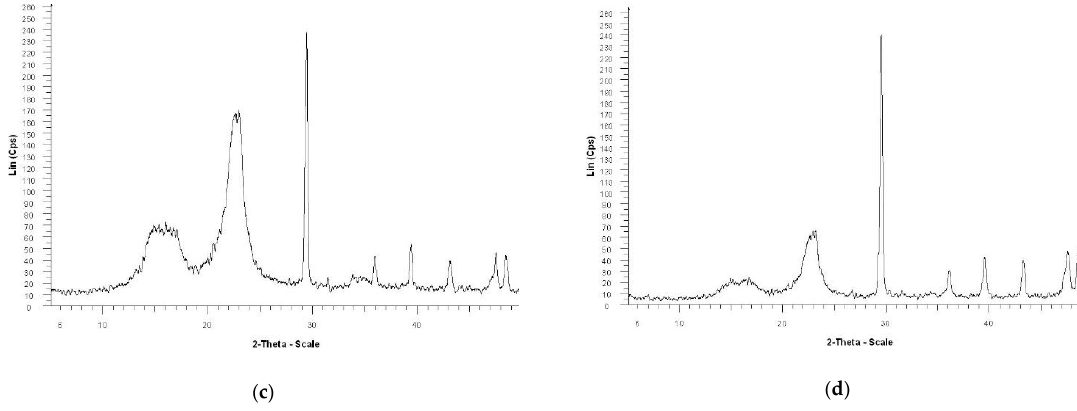
Figure 4. X-ray diffraction of paper samples and raw materials: ( a ) without loading; ( b ) CaCO 3 obtained from CaCl 2 / Na 2 CO 3 ; ( c ) in-situ loading; ( d ) conventional loading.